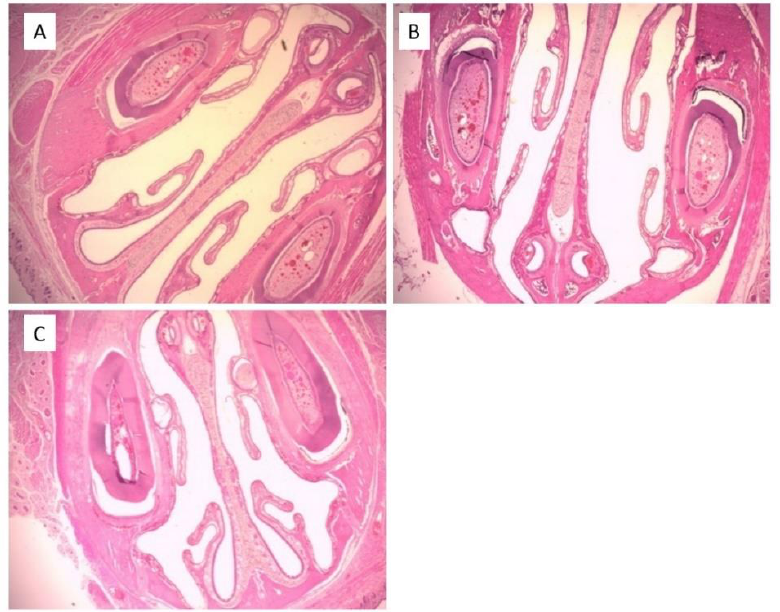
Figure 6. Representative micrographs of nasal cavities excised from rats ( A ) received no treatment ( B ) treated nasally with nasal nanovesicular carrier (NVS), and ( C ) treated nasally with normal saline (NS) (10×).